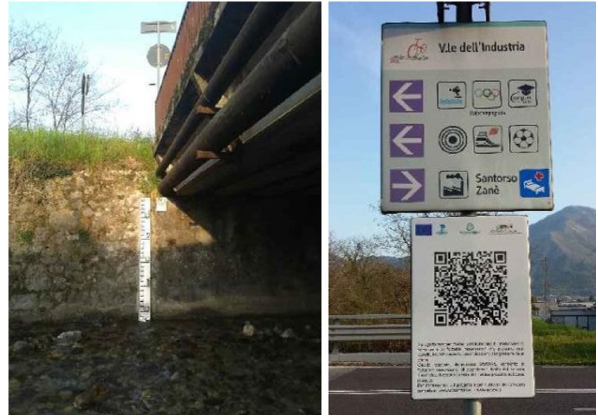
Figure 1. Photos showing staff gauges and QR codes used in the WeSenseIt